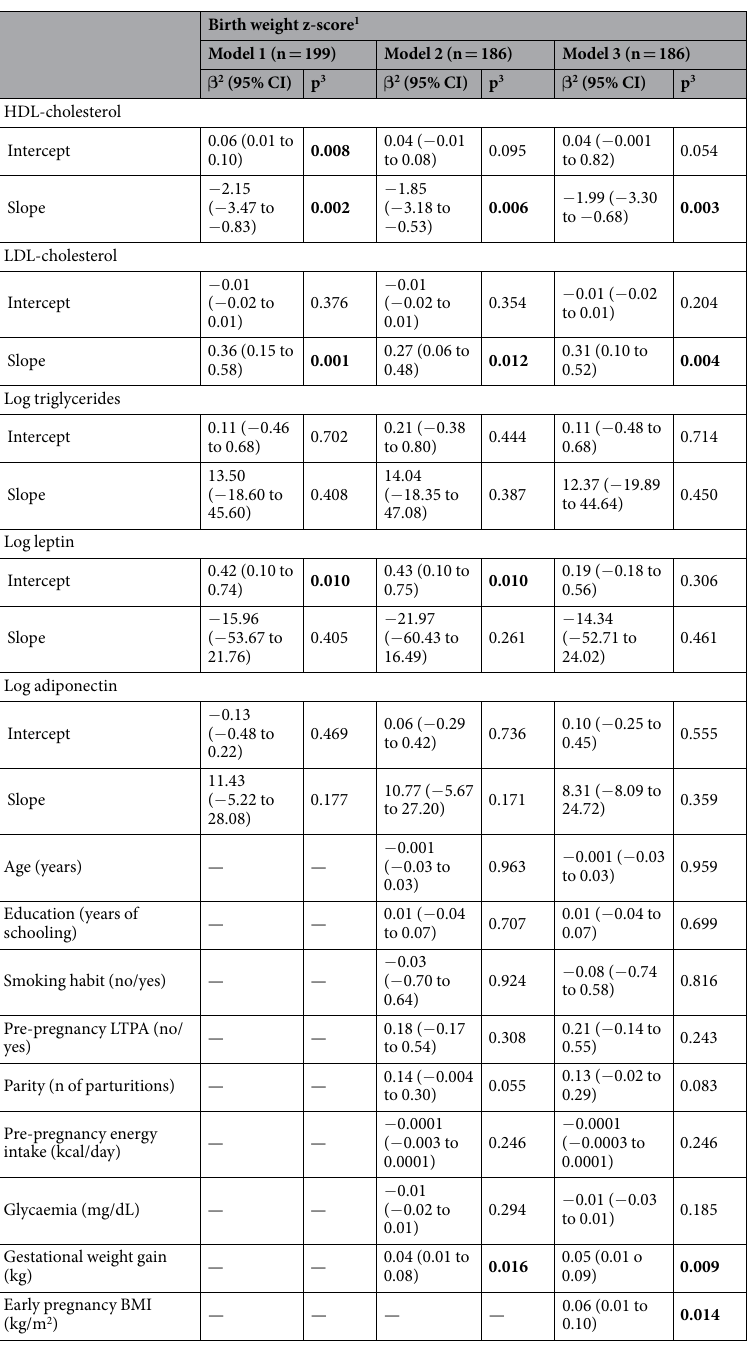
Table 5. Linear regression between maternal lipids, log leptin and log adiponectin time trends during pregnancy and birth weight z-score 1 in a sample of women and their newborns followed at a public health centre in Rio de Janeiro city, Brazil, 2009–2012. 1 Birth weight was classified according to the international foetal and newborn growth consortium for the 21 st Century (Intergrowth-21 st ) curves. 2 Linear regression coefficient. 3 p-value refers to the linear regression. Notes: Intercept variables represent the prediction of the mean exposure level, i.e. biomarkers concentrations when the gestational age was zero and the slope variables represent the trend of change in concentrations during pregnancy. Model 1 included lipid, leptin and adiponectin intercepts and slopes variables; Model 2 was additionally adjusted for women’s age, education, parity, smoking habit, pre-pregnancy practice of leisure time physical activity, pre-pregnancy energy intake, glycaemia and gestational weight gain. Model 3 was additionally adjusted for early pregnancy body mass index. Abbreviations: CI = confidence interval; HDL-c = high-density lipoprotein; LDL-c = low-density lipoprotein; LTPA = leisure time physical